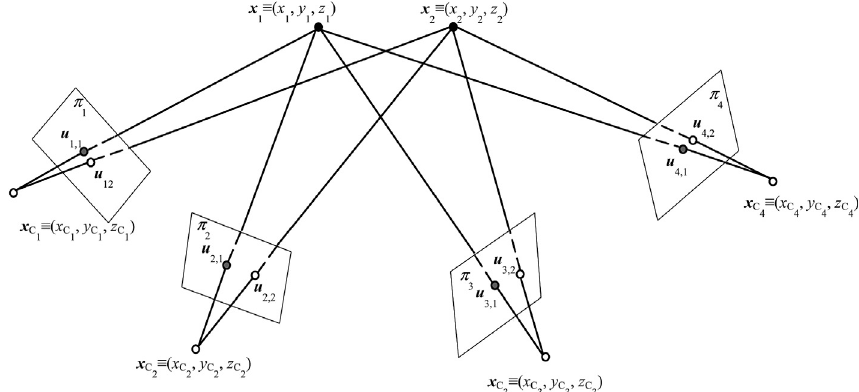
Fig. 3. Graphical representation of the localization problem when a setup of four cameras ( n c = 4) is used to reconstruct the 3D position of two markers ( m =